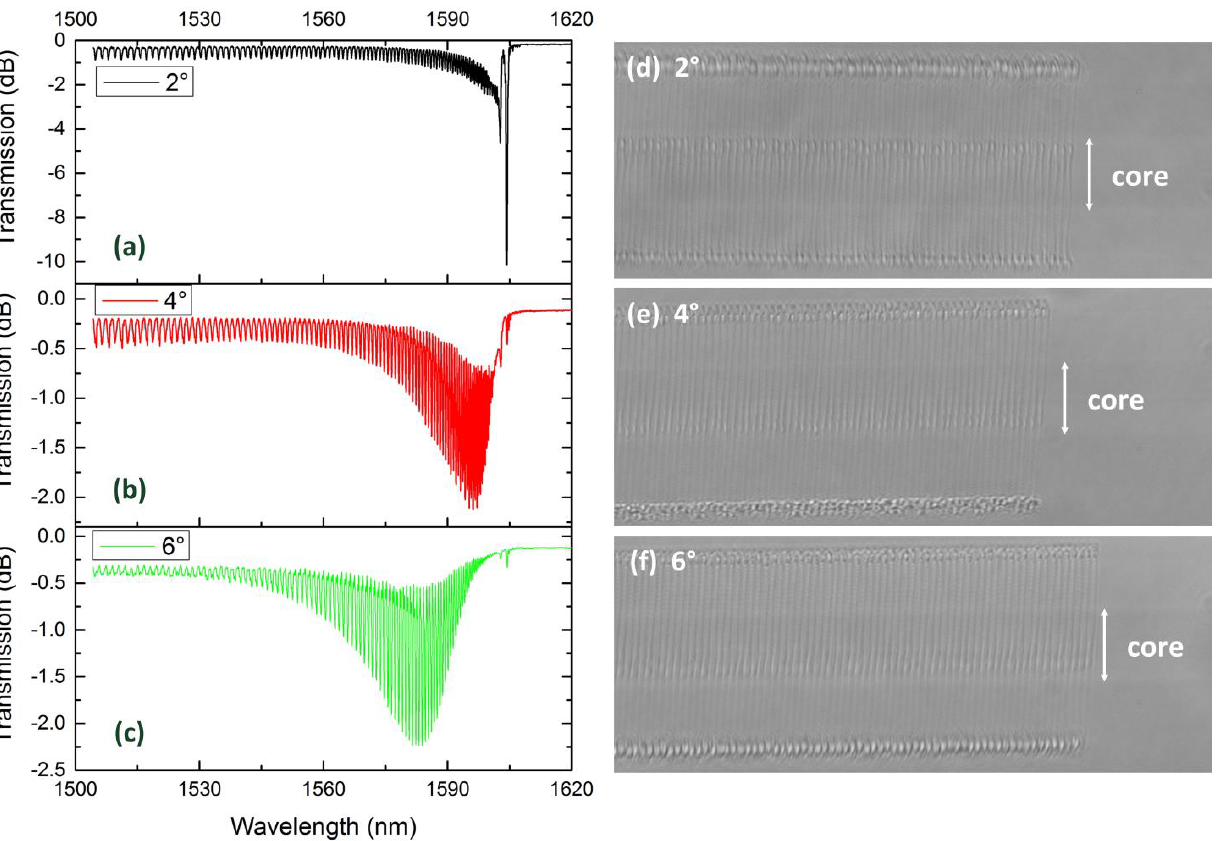
Figure 4. Transmission spectrum of ( a ) 2°TFBG, ( b ) 4°TFBG and ( c ) 6°TFBG, and microscopy image (100×) of ( d ) 2°TFBG, ( e ) 4°TFBG and ( f ) 6°TFBG. Figure 5 performs the transmission spectrum and microscopy image of 12°TFBG, 15°TFBG and 18°TFBG. Considering the limited wavelength range of sweeping wave- length laser, the period of grating is set as 1.13 μm. Except the similar phenomena ob- served in Figure 3, birefringence is clearly seen on the spectra. Dual dips phenomenon occurs within several resonance wavelengths. Comparing with Figure 4a–c, the envelop of cladding mode coupling becomes blurred. These phenomena are polarization-depend- ent.